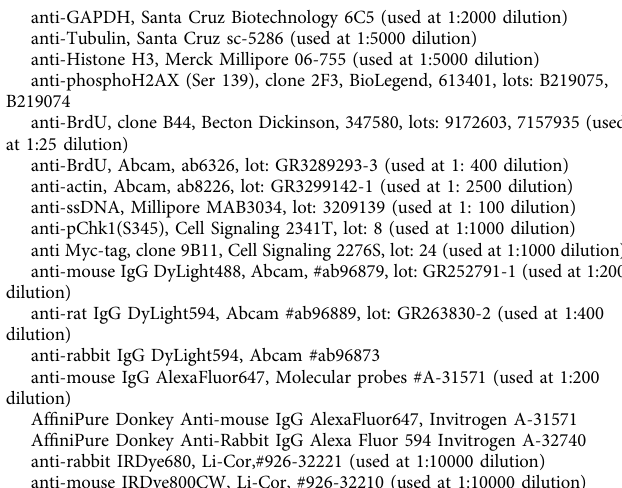
Fig. 8 RNAse H1 overexpression rescues cancer cell proliferation in the absence of INO80. a – d Cells from the indicated lines were co-transfected with control (siGFP) or INO80 targeting (siINO80) esiRNAs along with either a control (CTRL) or RNAse H1-overexpressing (oeRNAse H1) vector. Proliferation was monitored by cell counting 96 h after transfection. Expected values to test for independent effect of INO80 depletion and overexpression of RNAse H1 in cell growth are calculated according to 70 , as: V = [%growth siINO80] × [%growth oeRNAse H1]. Data are from 3 independent experiments. Exact p values: Fig. 8a = 0.1 for siRNaseH1 and 0.99 for siINO80 vs siGFP, Fig. 8b p -value = siGFP vs siINO80 = 0.047, p-value siGFP vs siINO80 = 0.007; p -value siINO80-siRNaseH1 vs predicted = 0.05. Figure 8c: p -value siGFP vs siINO80 = 0.009, siINO80-siRNaseH1 vs predicted = 0.046 Fig. 8d: p -value siGFP vs siRNaseH1 = 0.0005, p -value siGFP vs siINO80 > 0.0001, siINO80-siRNaseH1 vs predicted 0.0245 * p value < 0.05; **p-value < 0.01, *** p -value < 0.005; two-tailed unpaired Student ’ s t -test. Data are presented as mean values± SEM e Cell death analysis. PC3 cells transfected with control (siGFP), RNase H1-targeting (siRNaseH1) or INO80-targeting (siINO80) siRNAs for 24 h were treated with increasing concentrations of DL-Dopa for further 7 days incubation and analysed for cell growth (Supplementary Fig. 9f) and cytotoxicity. Cell death was calculated for cytotoxicity fl uorescence values normalized to the respective relative cell growth. Fold change cell death values were calculated by setting untreated control cells arbitrarily to 1. Concentrations used for DL-Dopa inhibitor: non-treated ( − ), 1 μ M, 2 μ M and 5 μ M. Data are presented as mean values ± SD, measure of centre is mean. Data are from three independent experiments. P values calculated by unpaired two-tailed t -test. (siGFP v siINO80 P value ** p = 0.0036, siGFP 2 μ M v siINO80 2 μ M P